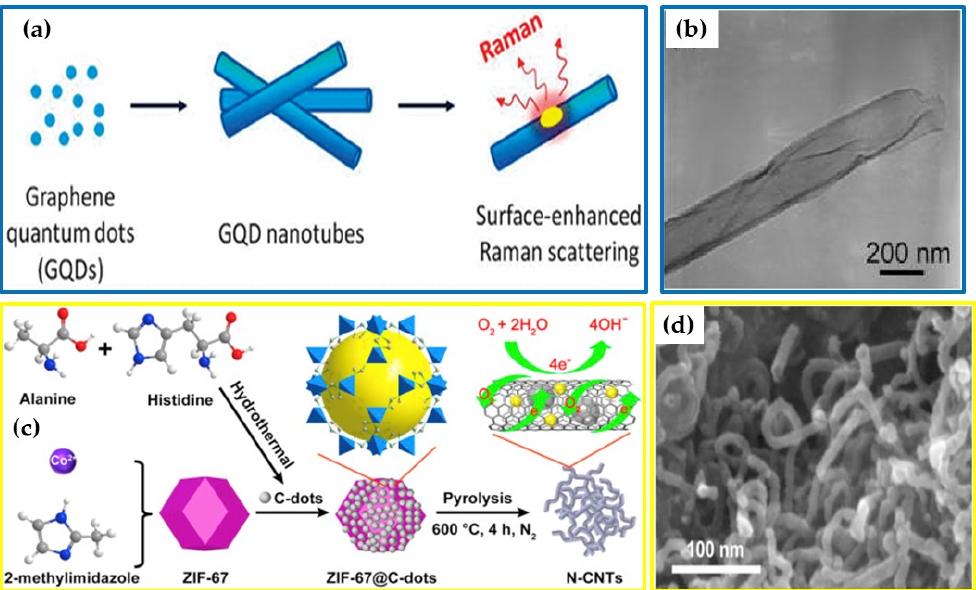
Figure 3. Illustrations of the formation of 1-D carbons from 0-D CNTs: ( a , b ) CNTs (adapted with permission from [100] , copyright 2012, American Chemical Society) and N-CNTs; ( c , d ) N-CNTs (reproduced with permission from [101] , copyright 2021, Elsevier BV).